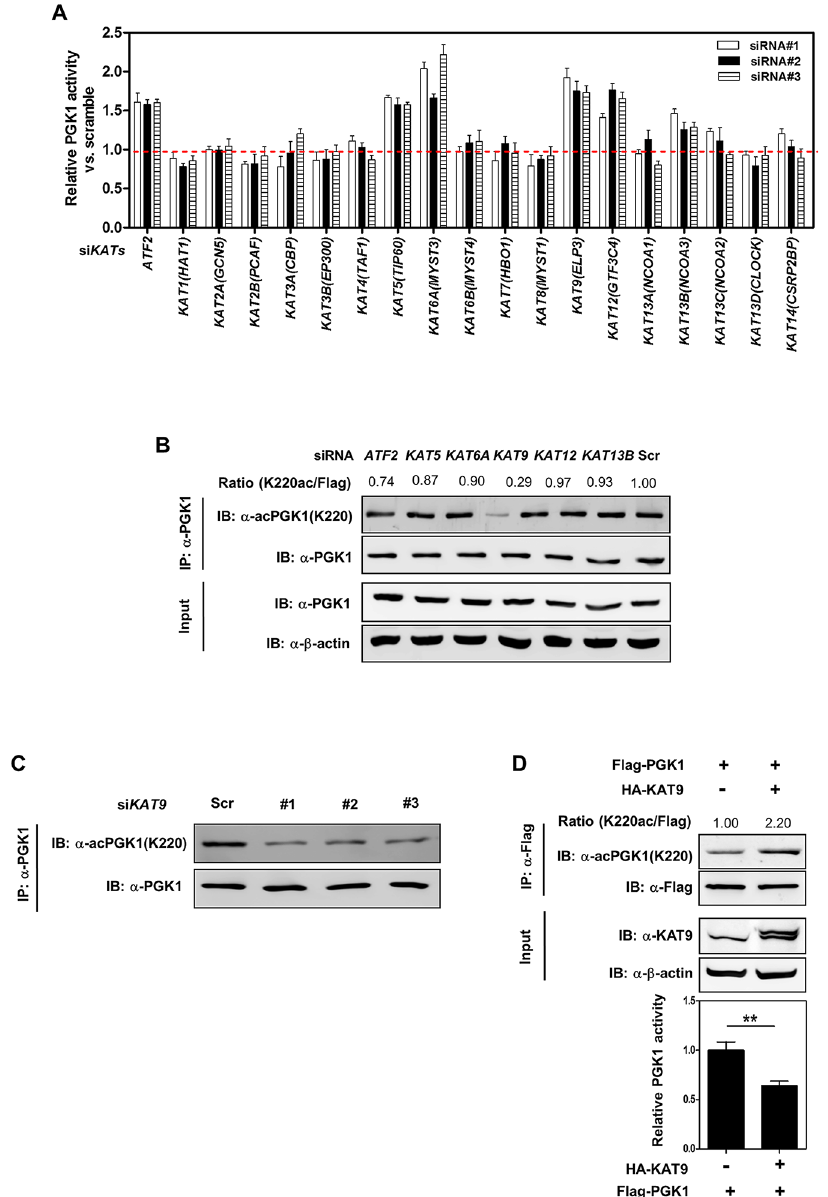
Fig 2. KAT9 acetylates PGK1 and inhibits PGK1 activity. ( A ) Knockdown of ATF2 , KAT5 , KAT6A , KAT9 , KAT12 , or KAT13B leads to increased enzyme activity of endogenous PGK1. HEK293T cells were transiently transfected with the indicated siRNAs. The enzyme activity of endogenous PGK1 was determined as described in “ Methods and Materials. ” ( B, C ) KAT9 knockdown leads to decreased K220 acetylation of endogenous PGK1. HEK293T cells were transiently transfected with the indicated siRNAs. The protein levels and K220 acetylation of endogenous PGK1 were determined by western blot (B). Moreover, HEK293T cells were transiently transfected with three different siRNAs targeting KAT9 , and the K220 acetylation level of endogenous PGK1 was determined by western blot (C). “ Scr ” means scramble. Relative PGK1 K220 acetylation levels were normalized against endogenous PGK1. ( D ) KAT9 overexpression increases PGK1 K220 acetylation and inhibits PGK1 enzyme activity. Flag-tagged PGK1 and HA-tagged KAT9 were transiently co-overexpressed in HEK293T cells, and PGK1 protein was purified by IP with Flag beads, the K220 acetylation level and enzyme activity of PGK1 were determined by western blot and enzyme assay, respectively. Relative PGK1 acetylation levels were normalized against Flag. Shown are average values with standard deviation (S.D.) of triplicated experiments. ** denotes the p < 0.01 for the indicated comparison; n. s. = not significant. The numerical data and statistical analysis used in the figures are included in S1 Data. Supporting information can be found in S5 Fig and S1